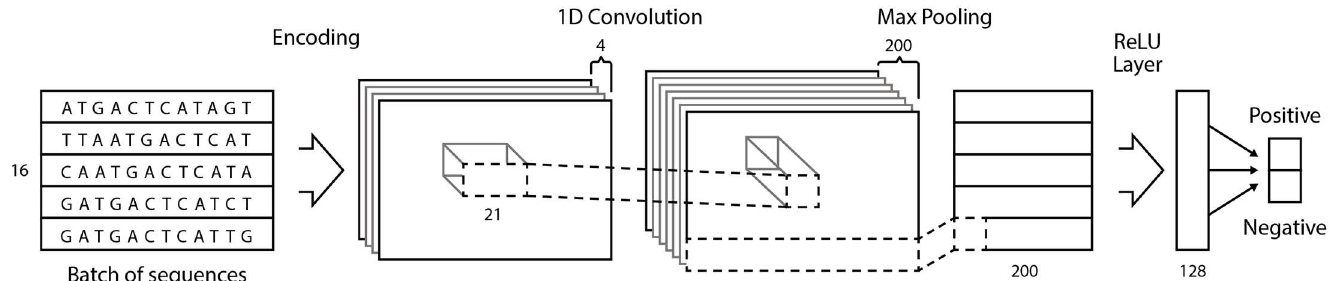
Fig 1. Basic CNN architecture that was used in building promoter models implemented in the learnCNN.py program (see text for